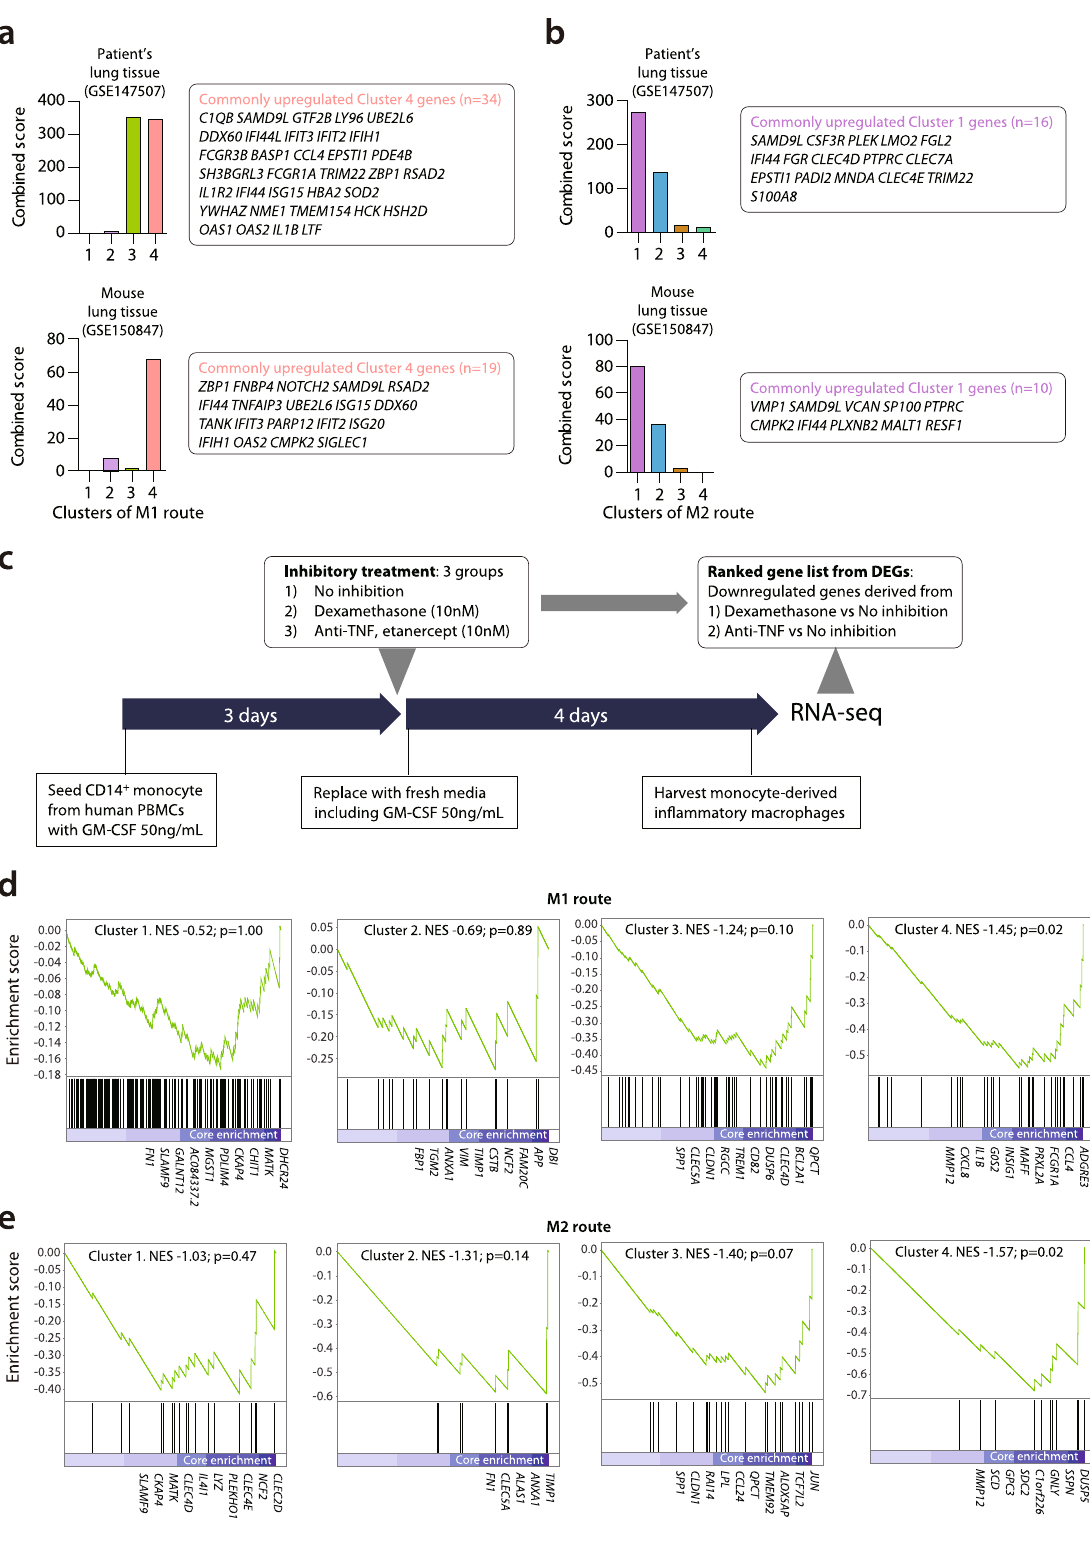
Methods Experimental ferrets . Experiments were performed using 14- to 20-month-old female ferrets ( n = 10, ID Bio Corporation, Cheongju, Korea) that were ser- ologically negative for in fl uenza A viruses (H1N1 and H2N2), MERS-CoV, and SARS-CoV. Ferrets were maintained in the isolator (Woori IB Corporation, Dae- jeon, Korea) in BSL3 of Chungbuk National University. All ferrets were group- housed with a 12-h light/dark cycle and allowed access to food and water. After two days of adaption to BSL3 conditions, the ferrets were intranasally inoculated with